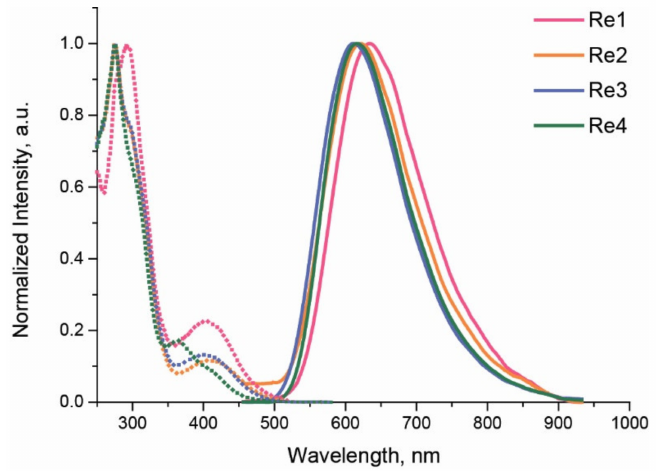
Figure 3. Normalized excitation (dotted line) and emission (solid line) spectra of Re1 – Re4 complexes in MeOH, at 20 ◦